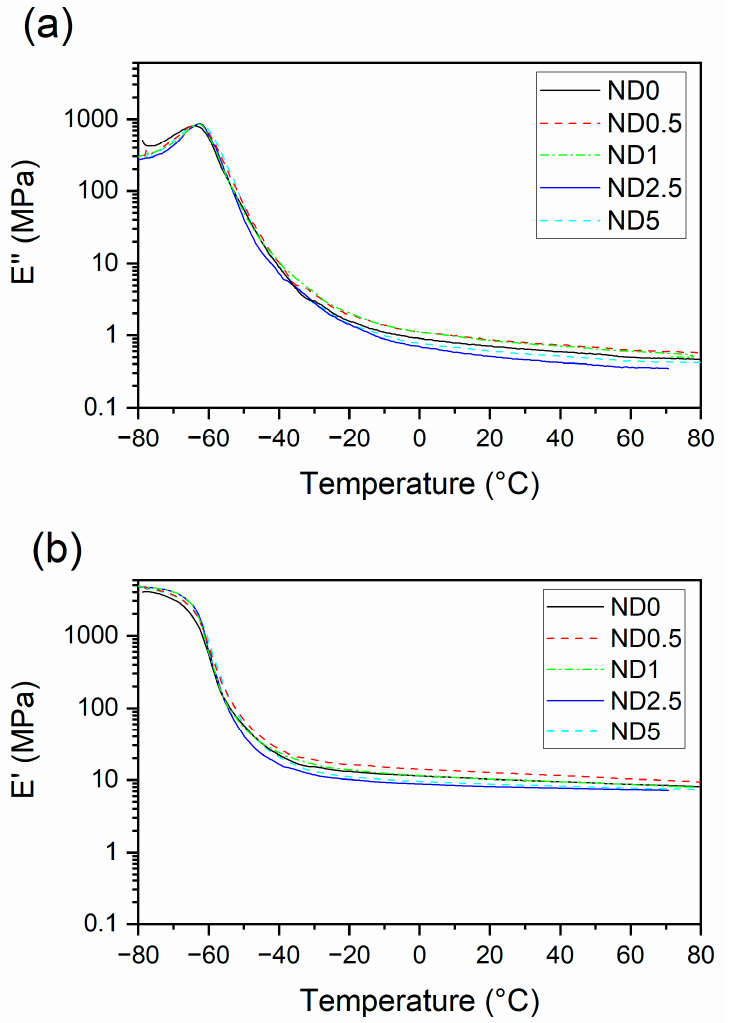
Figure 5. The effect of partial replacement of CB by NDs on ( a ) storage modulus, ( b ) loss modulus.